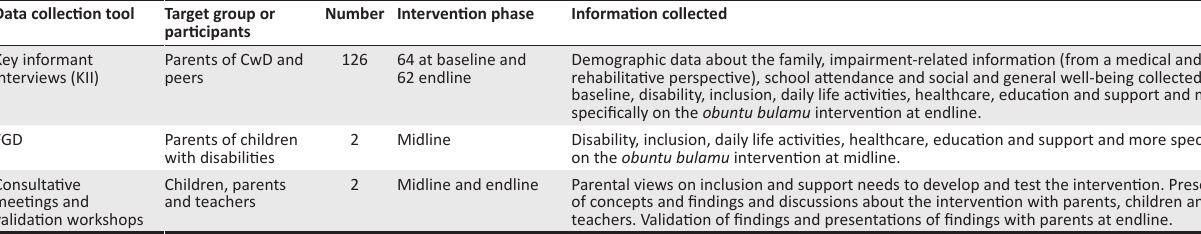
TABLE 1: Data collection tools, timelines and purpose. Data collection